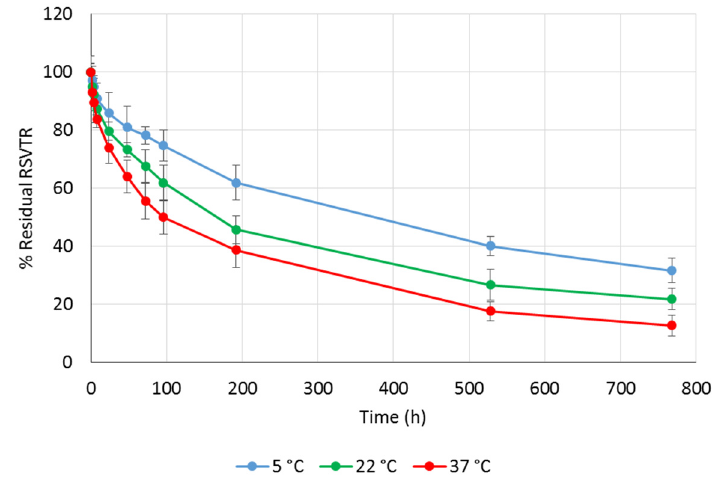
Figure 4. Percentage of residual RSVTR vs. time after incubation at pH 6.8 and different temperatures.